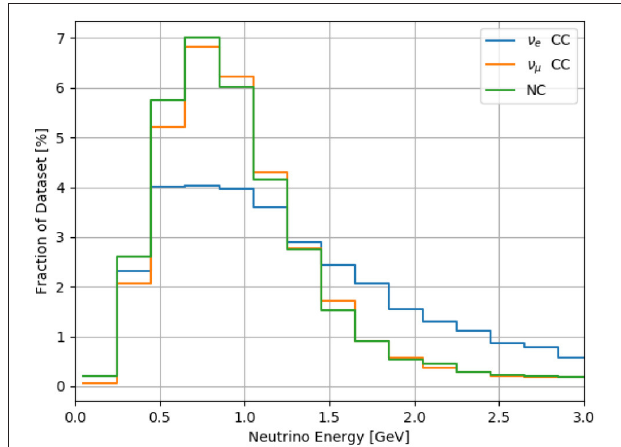
FIGURE 3 | Neutrino energy of interactions produced for this analysis. Most neutral current events are produced by muon-type neutrinos, and so the ν µ CC and Neutral Current energy spectra are similar. The relative populations here are for the dataset used in this paper, while in the neutrino beam the muon neutrino interactions are far more frequent than electron